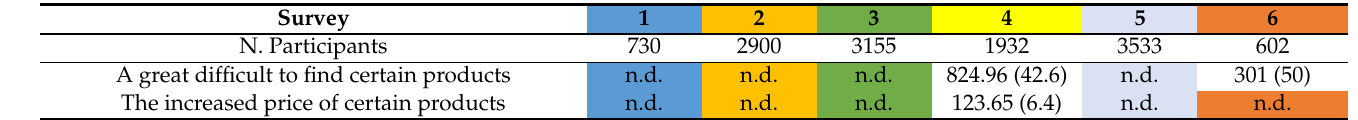
Table 10. Difficulty to find certain products, absolute value (N.) and (%) on the total.